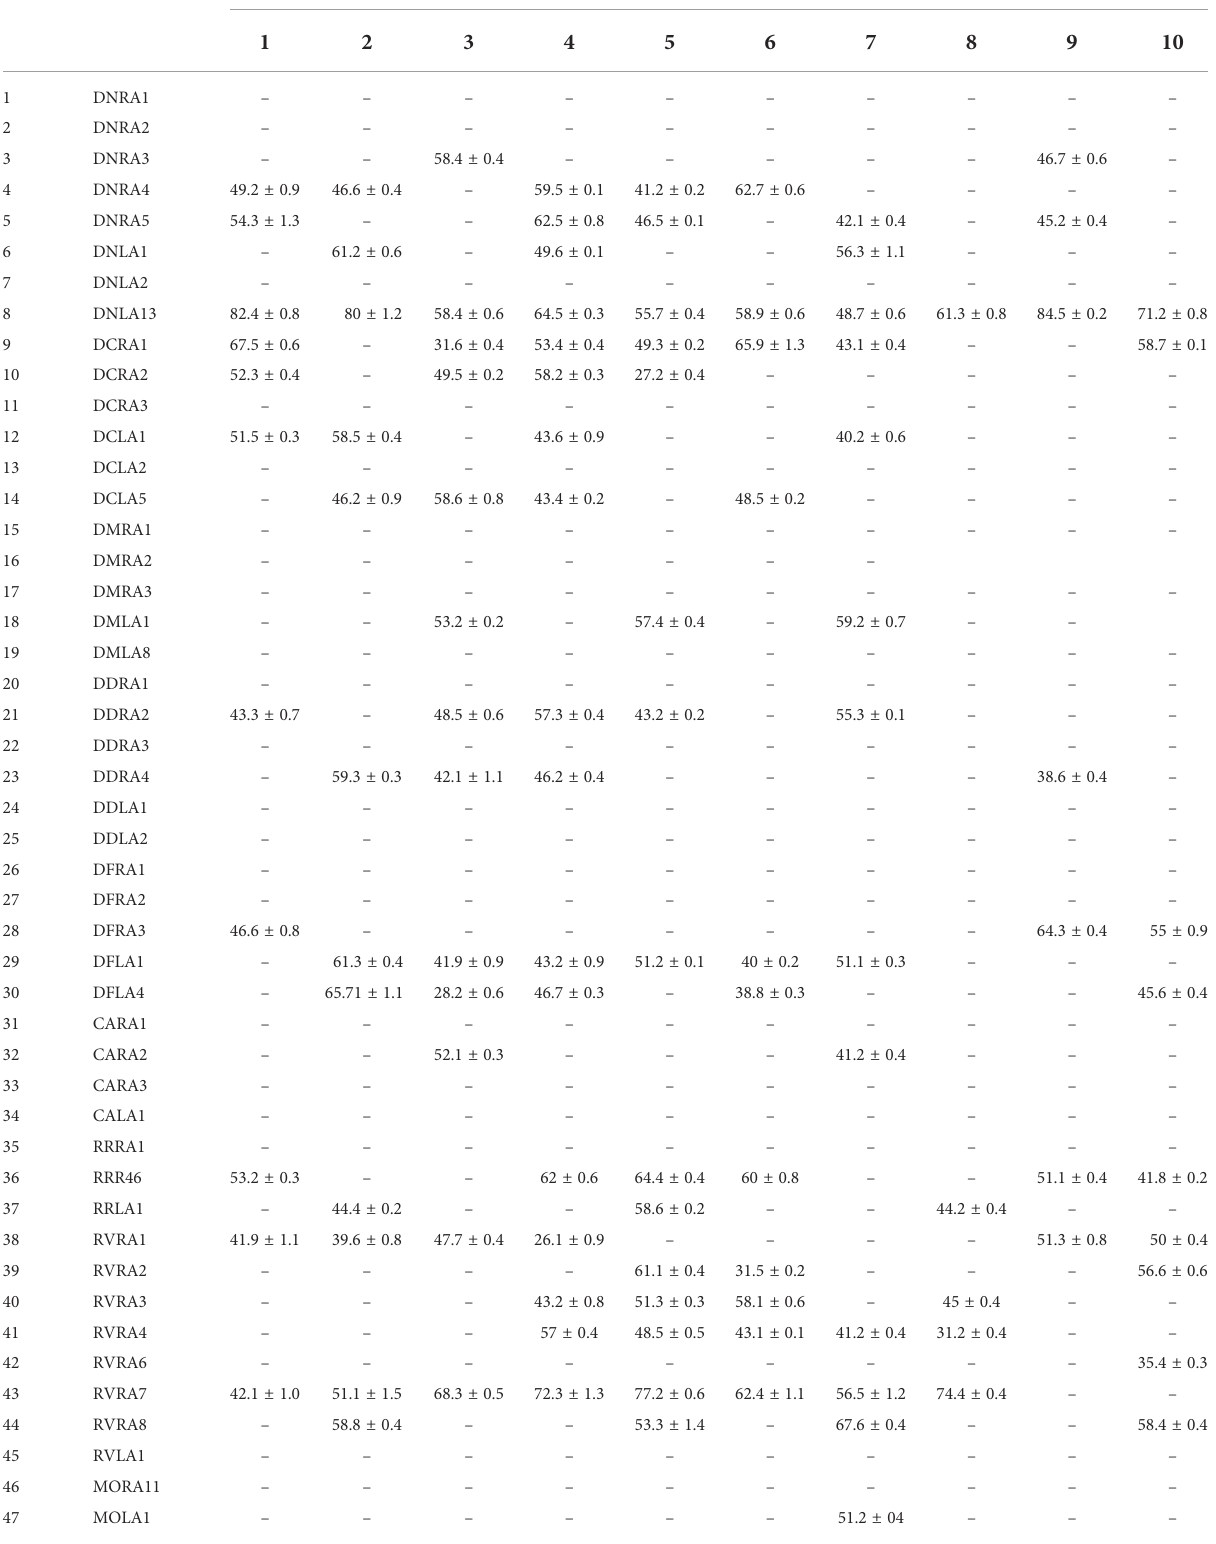
TABLE 3 Antifungal activity of endophytic actinobacteria associated with orchid against ten fungal plant pathogens. Sl.